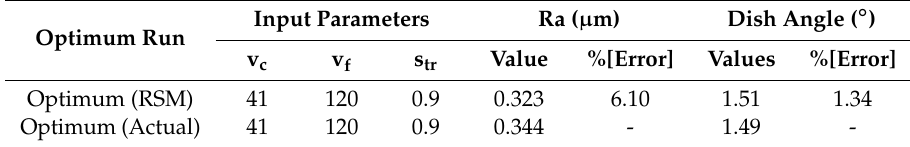
Table 7. Optimum parameter level and output